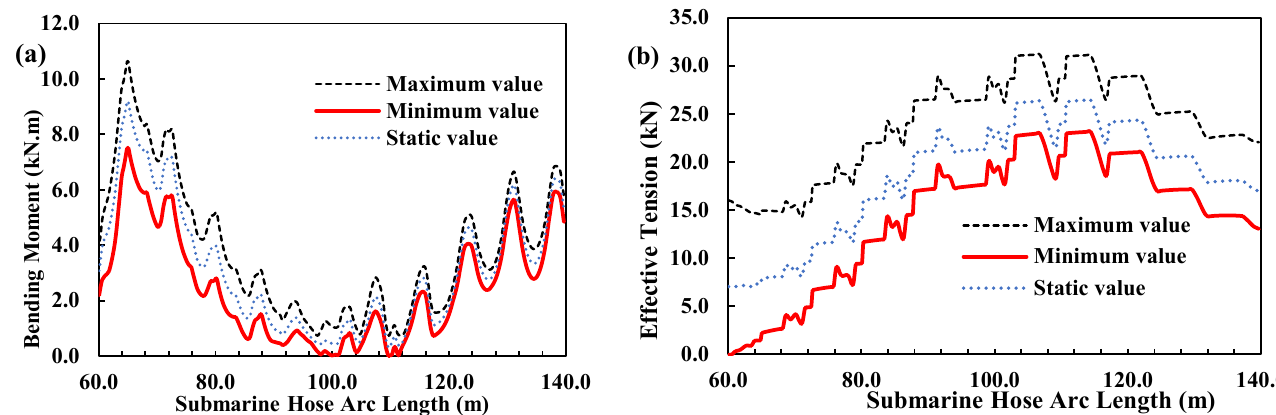
Figure 30. Effect of Float outer diameter on the submarine hoses. ( a ) Bending Moment for hose arc lengths 60–140 m. ( b ) Effective Tension for hose arc lengths 60–140 m.